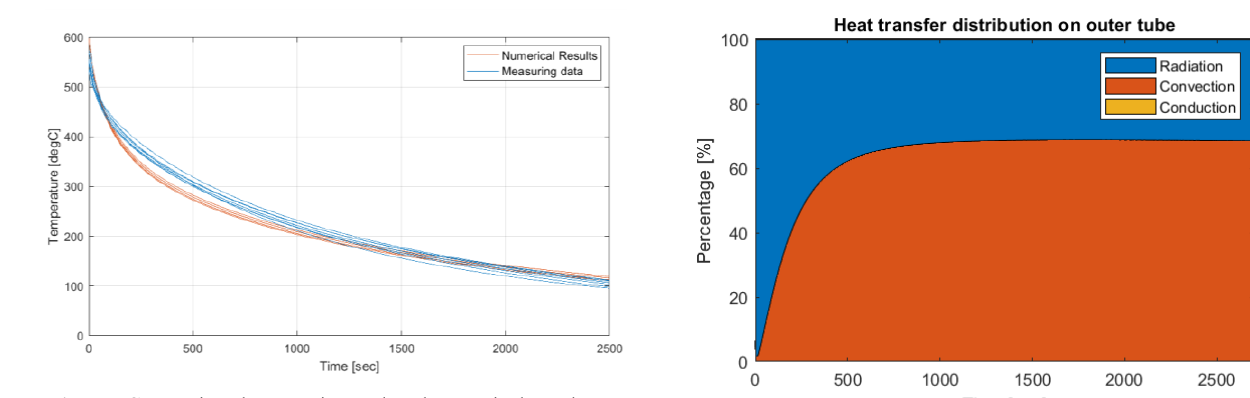
Fig. 18. Comparing the experimental and numerical results on middle tube .